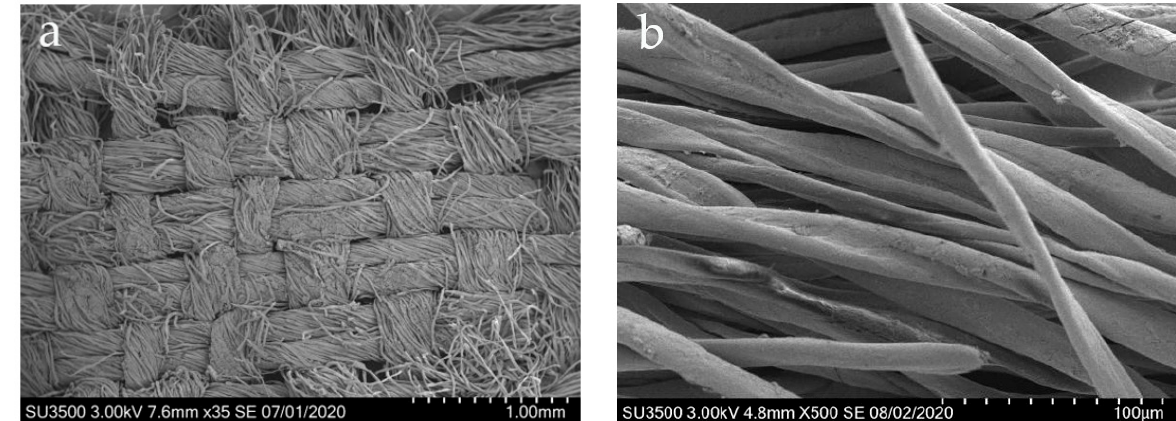
Figure 3. SEM image of Sample 1. ( a ) 100×; ( b ) 1000×.